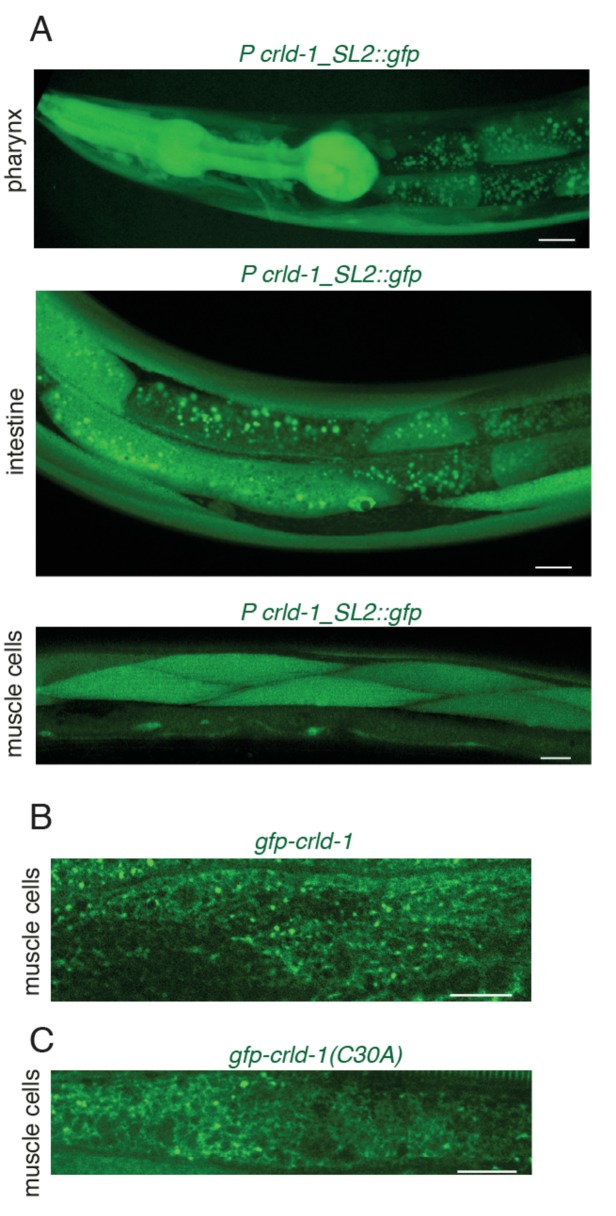
- CRLD-1 expression pattern.(A) Confocal images of transgenic animals expressing GFP under the control of crld-1 promoter (pTB208 Pcrld-1::SL2::gfp). CRLD-1 is expressed in several tissues: pharynx, intestine and muscles. Scale bars: 10 μm. (B) Localization of CRLD-1 in muscle cells from gfp-crld-1(kr298) knock-in worms expressing both crld-1a and crld-1b isoforms. CRLD-1 reticular network is present in combination with a punctate pattern. Scale bar 10 μm. (C) Localization of CRLD-1 in muscle cells from gfp-crld-1(C30A) knock-in worms expressing both crld-1a and crld-1b isoforms. CRLD-1 reticular network is present in combination with a punctate pattern. Scale bar: 10 μm.